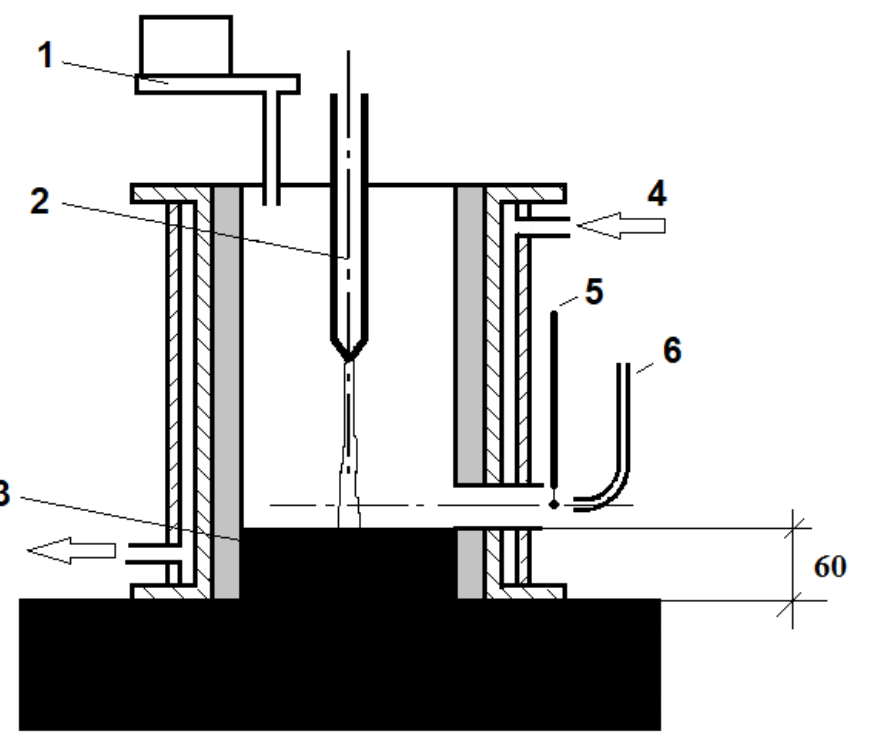
Figure 2. The scheme of the plasma-chemical reactor. 1—raw material input, 2—plasma torch, 3—graphite plate (anode), 4—cooling flow inlet, 5—Chromel–Alumel thermocouple, 6—cooled probe for gas sampling.